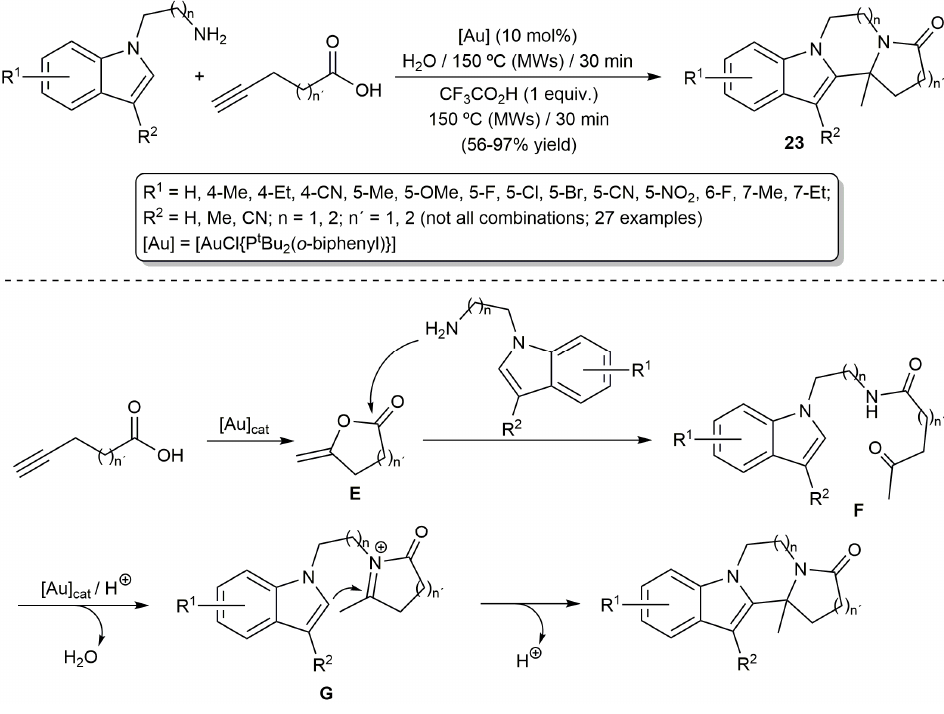
Scheme 13. Gold-catalyzed synthesis of fused polycyclic indoles in water.